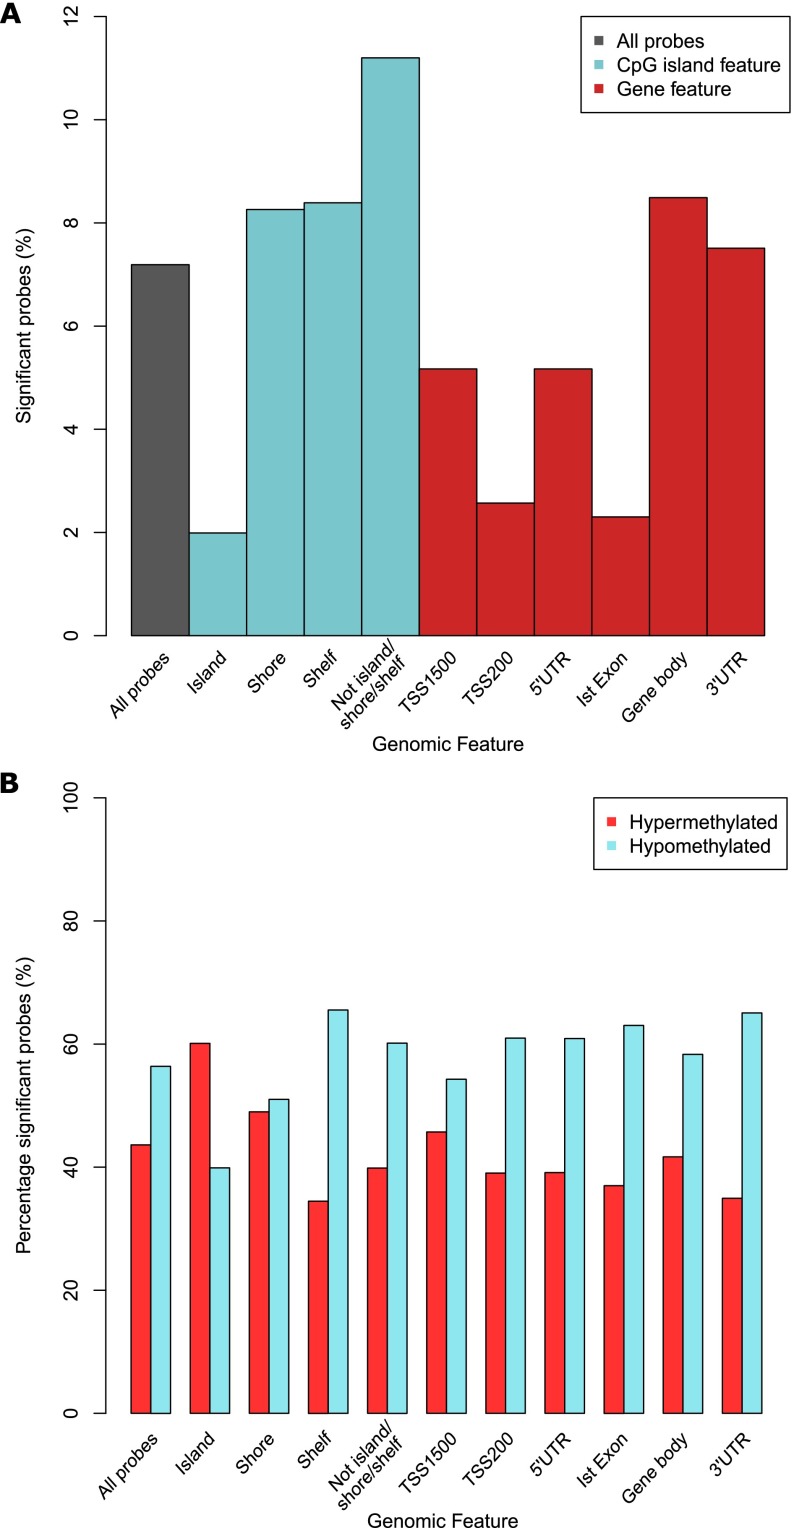
The distribution and direction of fetal brain dDMPs differs markedly across genomic features. (A) Compared to the genome average, dDMPs are significantly underrepresented in CpG islands, transcription start-sites, 5′ UTRs, and first exons, but significantly enriched in CpG island shores, CpG island shelves, and the gene body (see also Table 2). (B) There is an overall enrichment of hypomethylated fetal brain dDMPs (P = 6.74 × 10−53), but CpG islands are unique in showing an enrichment for sites becoming hypermethylated with fetal brain development (P = 2.00 × 10−13) (see also Table 2).